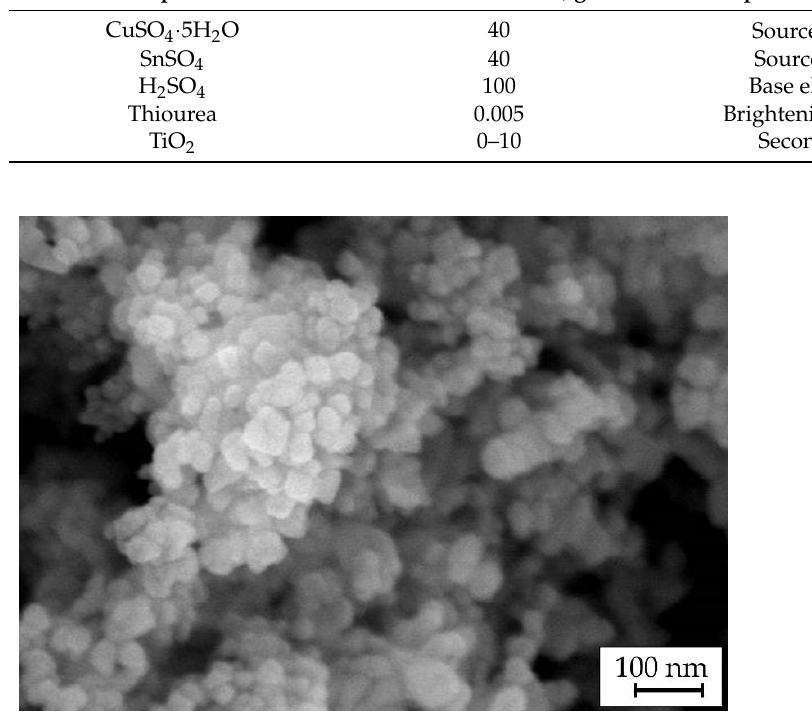
Figure 1. SEM image of Degussa P25 TiO 2 powder used in this